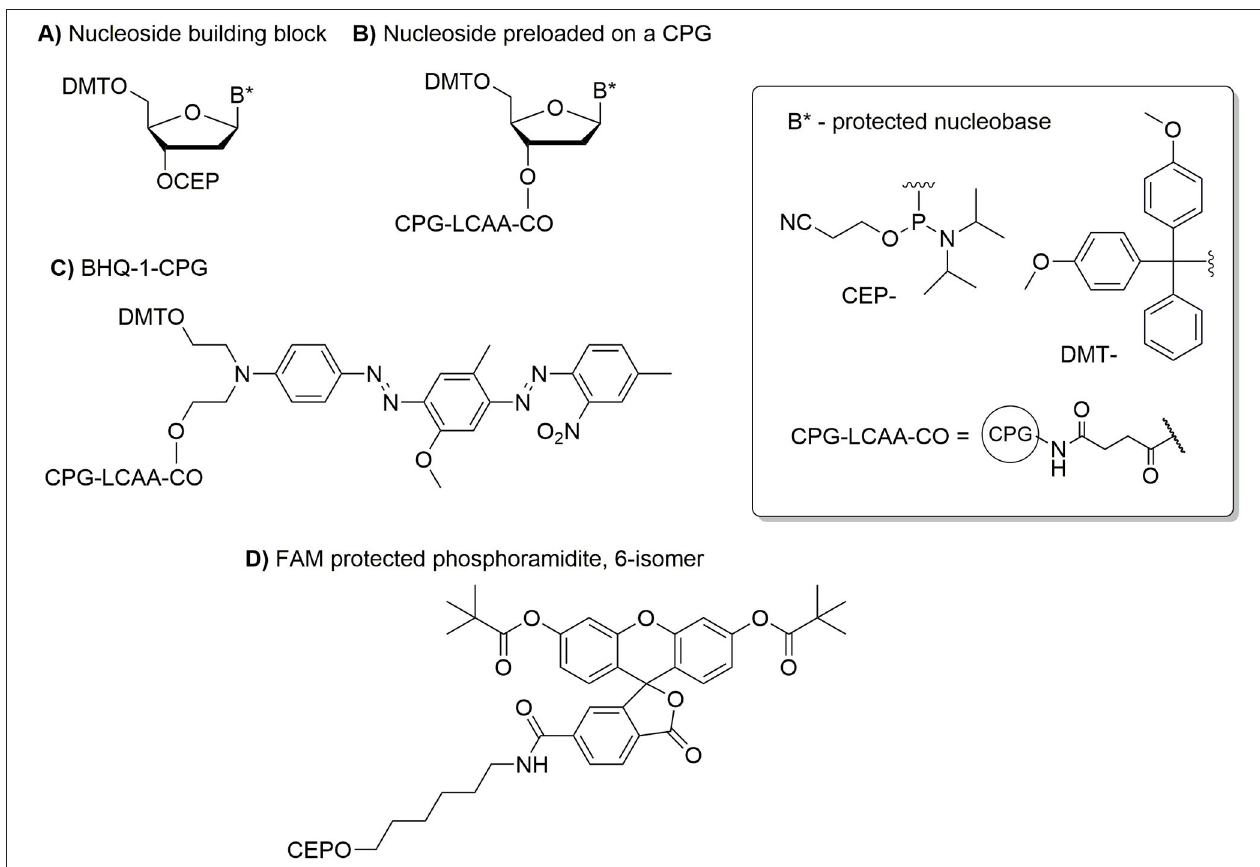
FIGURE 4 | DNA monomers used for the synthesis of DNA primers and probes. (A) Structure of a 5 ′ - O -DMT protected nucleoside phosphoramidite used for an automated DNA synthesis. (B) Structure of a 5 ′ - O -DMT protected nucleoside bound to the CPG-support and used as the first nucleotide at the 3 ′ -end of the DNA sequence. (C) Structure of a DMT-protected BHQ-1 bound to the CPG support and used for the synthesis of DNA probes with BHQ-1 present at 3 ′ -end. (D) Structure of fluorescein containing phosphoramidite used for installation of fluorescein at the 5’end of the DNA